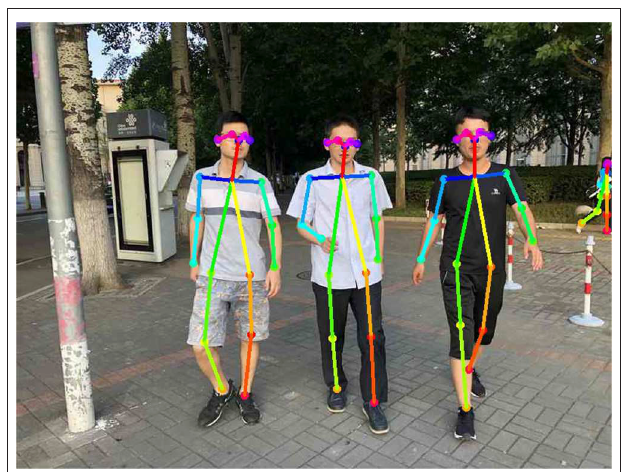
FIGURE 2 | Result of the human pose-estimation system. Written informed consent for publication was obtained from the individuals in this